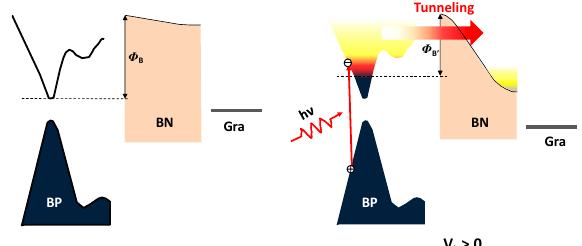
Figure 3. Proposed diagram for the photogenerated carriers in the junction and modulation of the photocurrent at zero bias and positive bias. Φ B and Φ B’ are the barrier from boron nitride (h-BN).